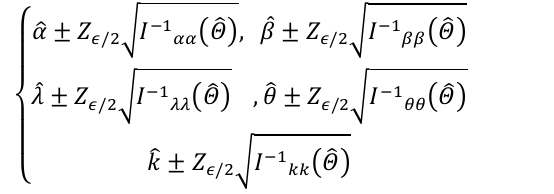
Table 1. Maximum likelihood estimates- bladder cancer data